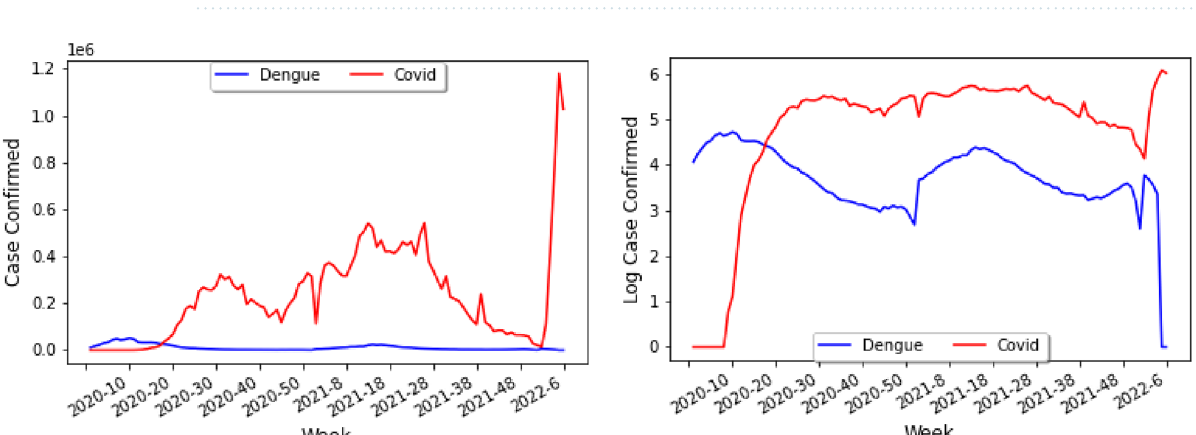
Figure 4. Plot of data of reported cases from the Pan- Ameri can Healt h Organ izati on Datas et on Dengue and the World Health Organization dashb oard on COVID- 19 (left) and its log plot